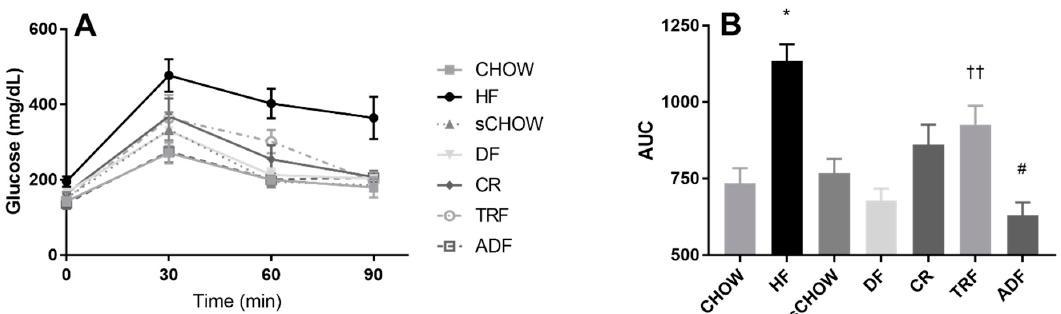
Figure 4. Post-intervention glucose tolerance test ( A ) area under the glucose curve (AUC) ( B ) of male C57BL/6 mice assigned to seven different dietary protocols for eight weeks. Values are mean ± SEM, n = 7–9 mice per group, ANOVA. ( B ) *A significant group effect noted: HF > CHOW, sCHOW, DF, CR, and ADF ( p < 0.050); †† A significant group effect noted: TRF > DF and ADF ( p < 0.050); # A